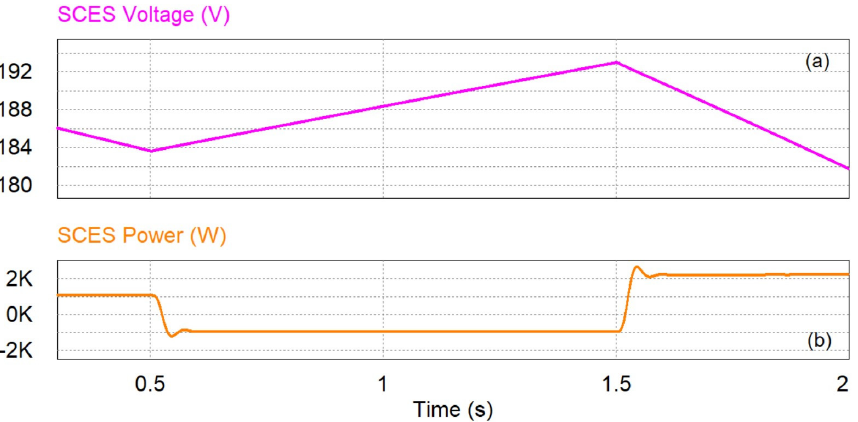
Figure 11. ( a ) The SCES voltage; ( b ) the SCES power—Case 1. Energies 2023 , 16 , x FOR PEER REVIEW